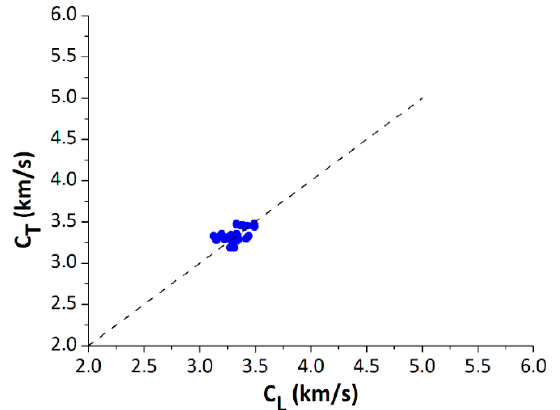
Figure 9. Propagation velocity of the standing trees (C T ) versus the propagation velocity of the logs (C L ), for Plantation 3.